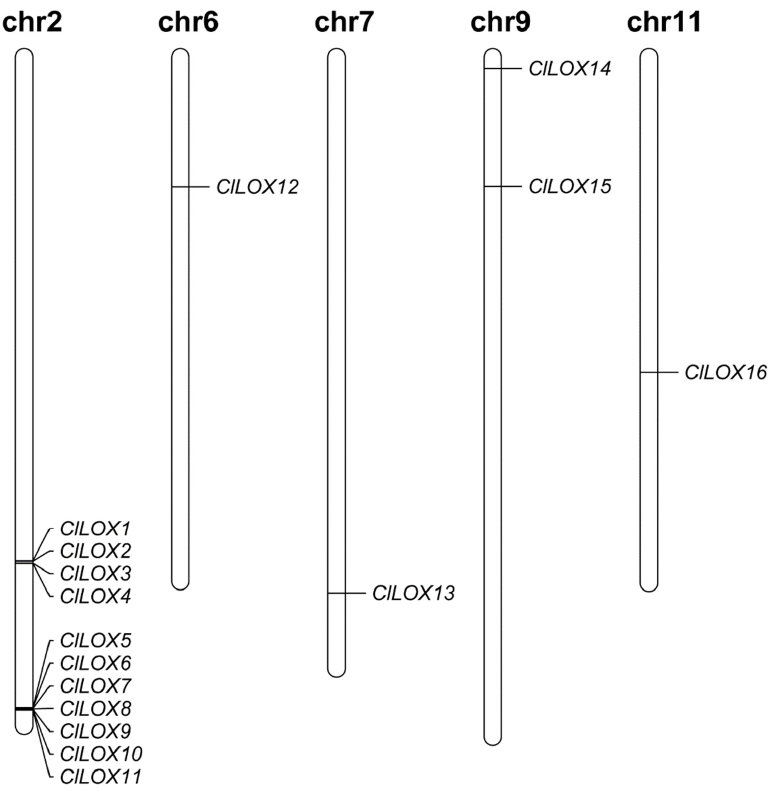
Figure 3. Locations of the LOX genes in watermelon chromosomes.